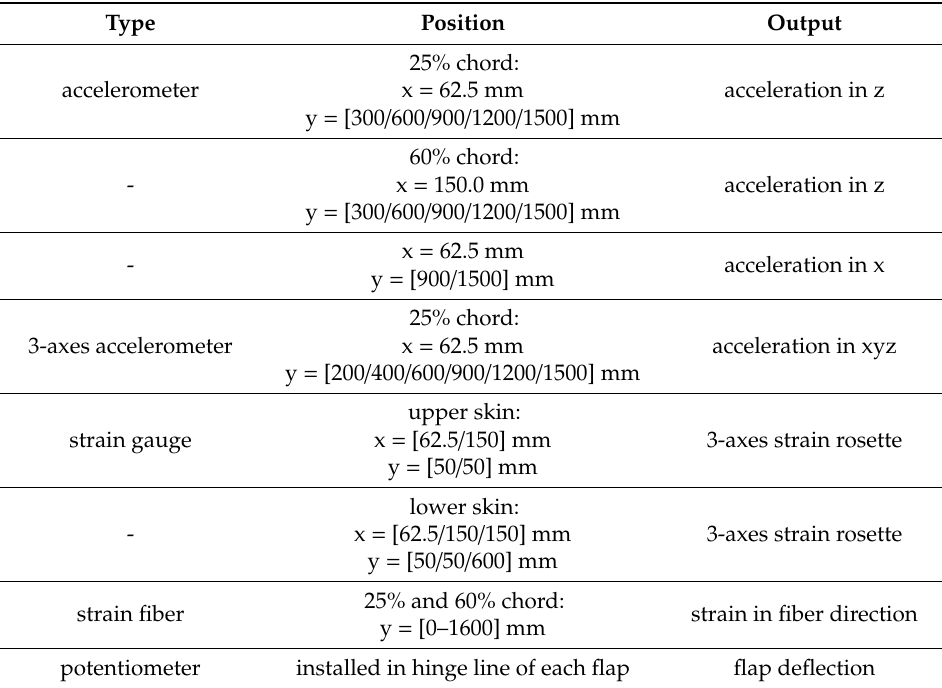
Table 3. Sensors installed in the